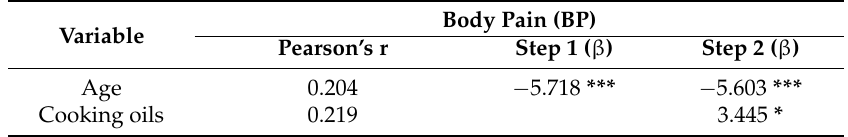
Table 5. Stepwise regression predicting the BP scores.